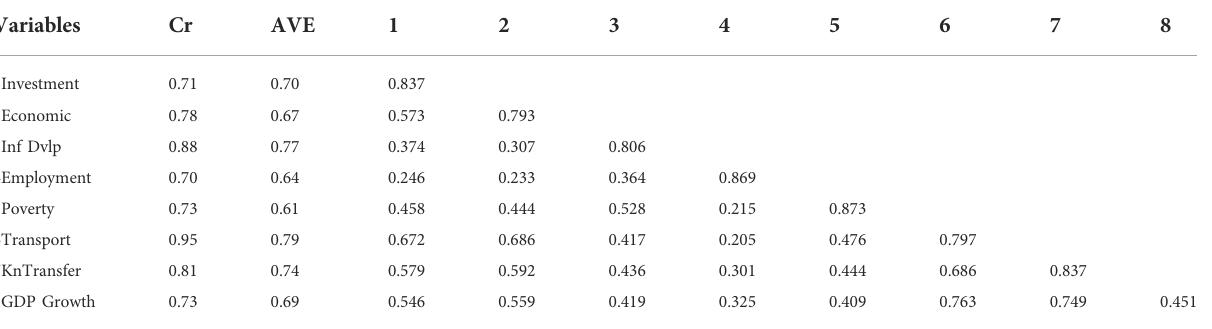
TABLE 7 Pearson correlation